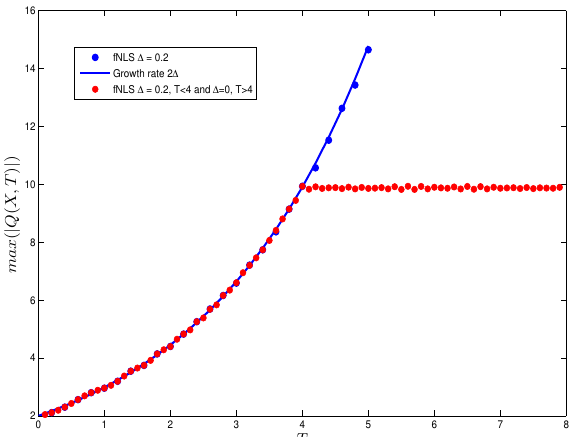
Figure 6. Case 2: Maximum of | Q ( X , T ) | and growth rate 2 ∆ when (cid:101) = 1.0, M = 2, K = − 2, and ∆ = 0.2, forcing is turned off when T >